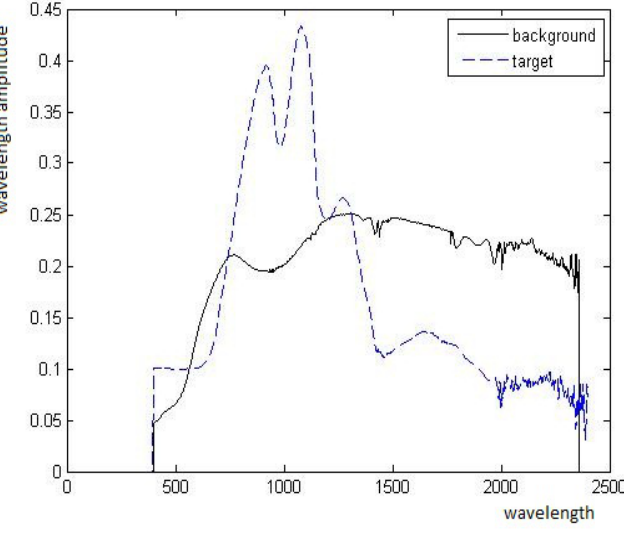
the b partition of [0 , 1] , ε = 0 . 01 . The vertical axes of the left images represent the cardinality of the coordinate’s set that belongs to each interval in the b